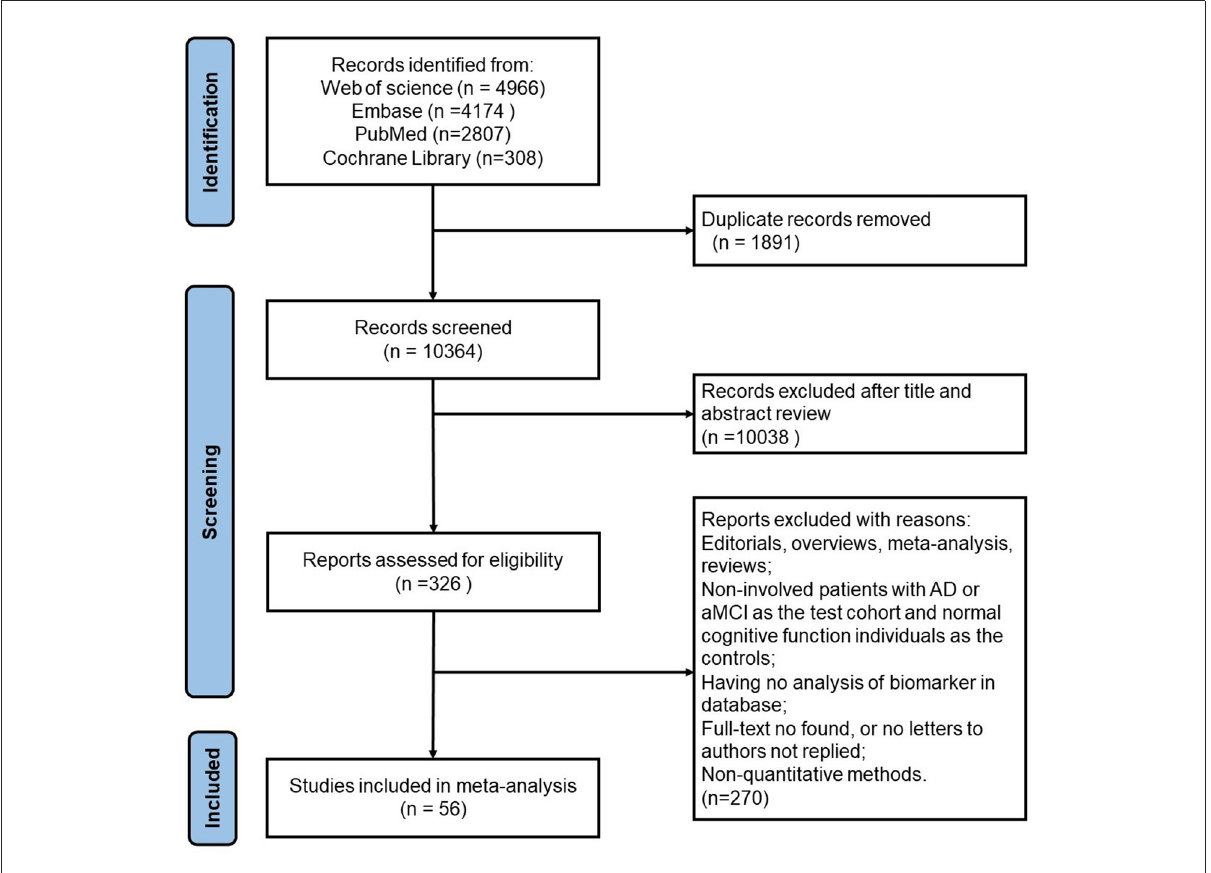
FIGURE1 Study selection